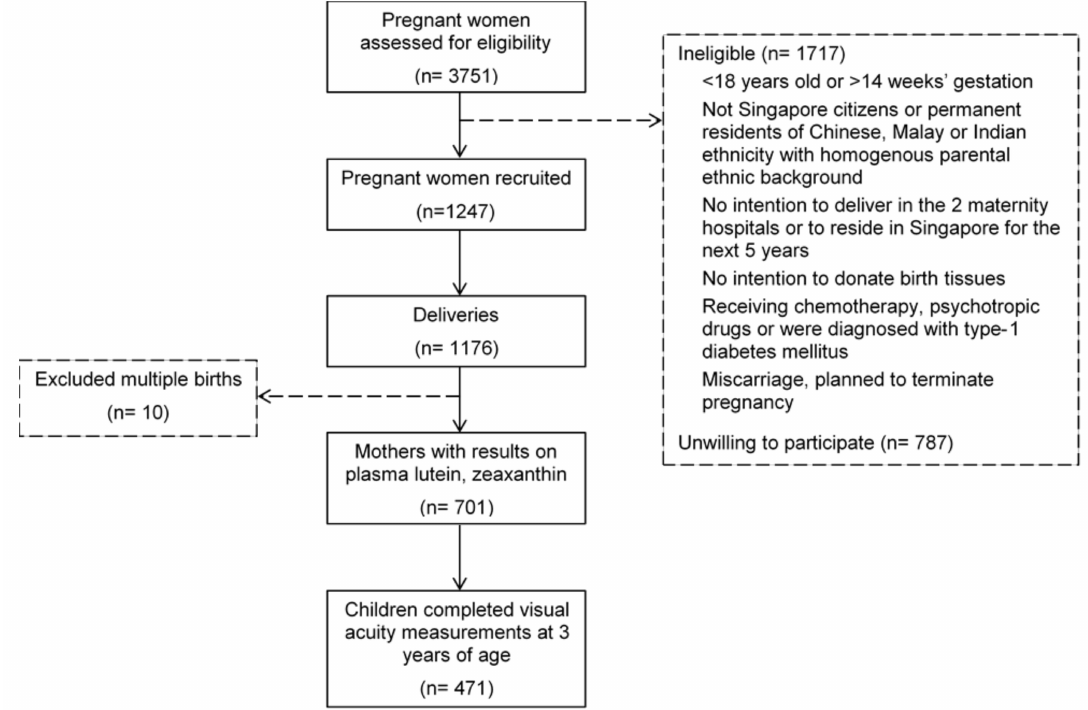
Figure 1. Flowchart of participants selected for analysis of associations of maternal plasma lutein and zeaxanthin with o ff spring visual acuity in the Growing Up in Singapore Towards healthy Outcomes